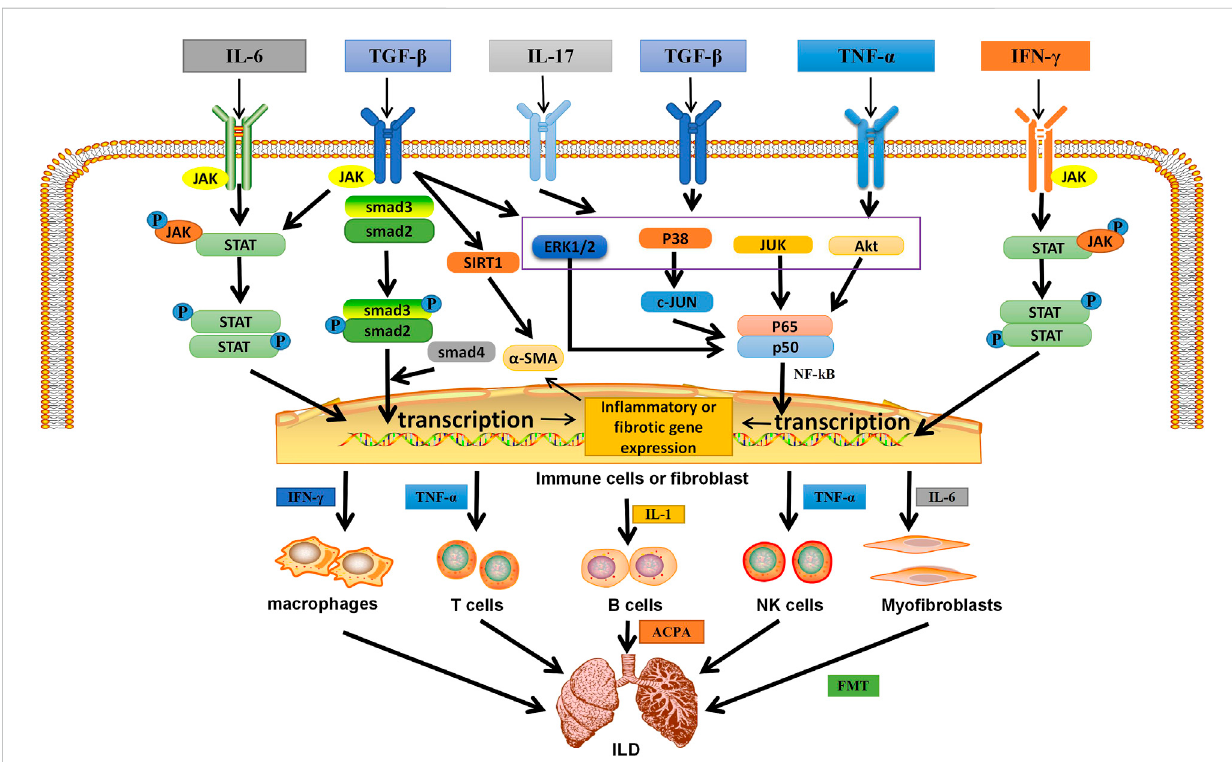
FIGURE 2 The related mechanism of ILD occurrence. Cytokines and growth factors, after binding to their corresponding receptors in immune cells or myo fi broblasts, can be activated through different signal transduction pathways. Activated immune cells can secrete a variety of cytokines. They further activate macrophages; T, B, and NK cells; and myo fi broblasts. They are over-activated and can secrete pro-in fl ammatory and pro- fi brotic cytokines, which is the environment for the formation of in fl ammation and fi brosis in the lung. Meanwhile, in different autoimmune diseases, B cells secrete corresponding antibodies, which are related to pulmonary fi brosis. In addition, IL-6 can activate myo fi broblasts, causing them to undergo EMT and form ECM, which is deposited in the lung. Eventually ILD is formed. IL, interleukin; TGF- β , transforming growth factor β ; IFN- γ , interferon- γ ; TNF- α , tumor necrosis factor; P, phosphate; JAK, janus tyrosine kinase; STAT, signal transducers and activators of transcription; ERK1/2,extracellular signal-regulated protein kinases; AKT, serine-threonine kinase; NF- κ B, nuclear factor-kappa B; SIRT1, sirtuin1; α -SMA, α -smooth muscle actin; ACPA, anticitrullinated peptide antibodie; ECM,extracellular matrix; EMT, epithelial-mesenchymal transition; ILD,Interstitial lung